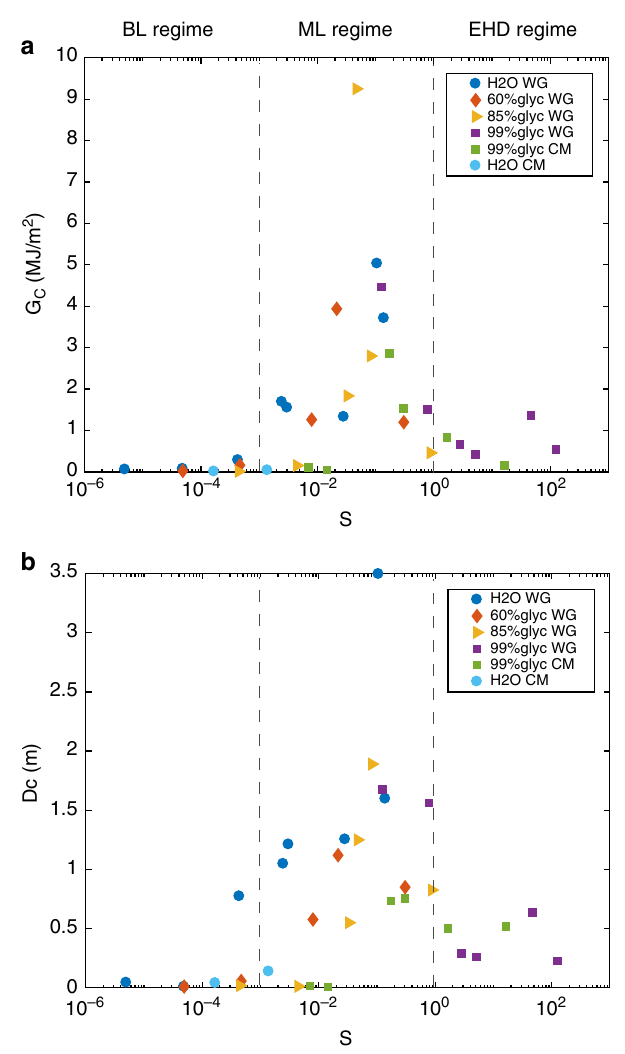
Fig. 3 Fracture energy and D c vs. Sommerfeld number. The three lubrication regimes (BL, ML, and EHD) are delimited by vertical black dashed lines. Experiments were performed at acceleration of 6.5 m s − 2 , effective normal stress σ eff up to 20 MPa in the presence of water, mixtures of glycerol, and water and pure glycerol (see symbols in the fi gure where WG is Westerly Granite and CM is Carrara Marble. a Fracture energy vs.